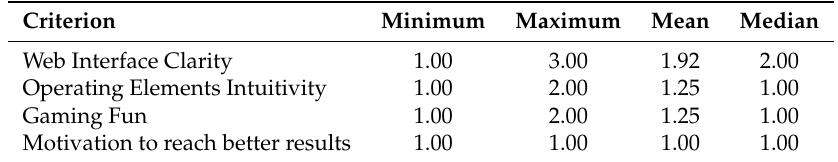
Table 2. Questionnaire evaluation results (evaluation using school grades from 1 to 5 where lower is